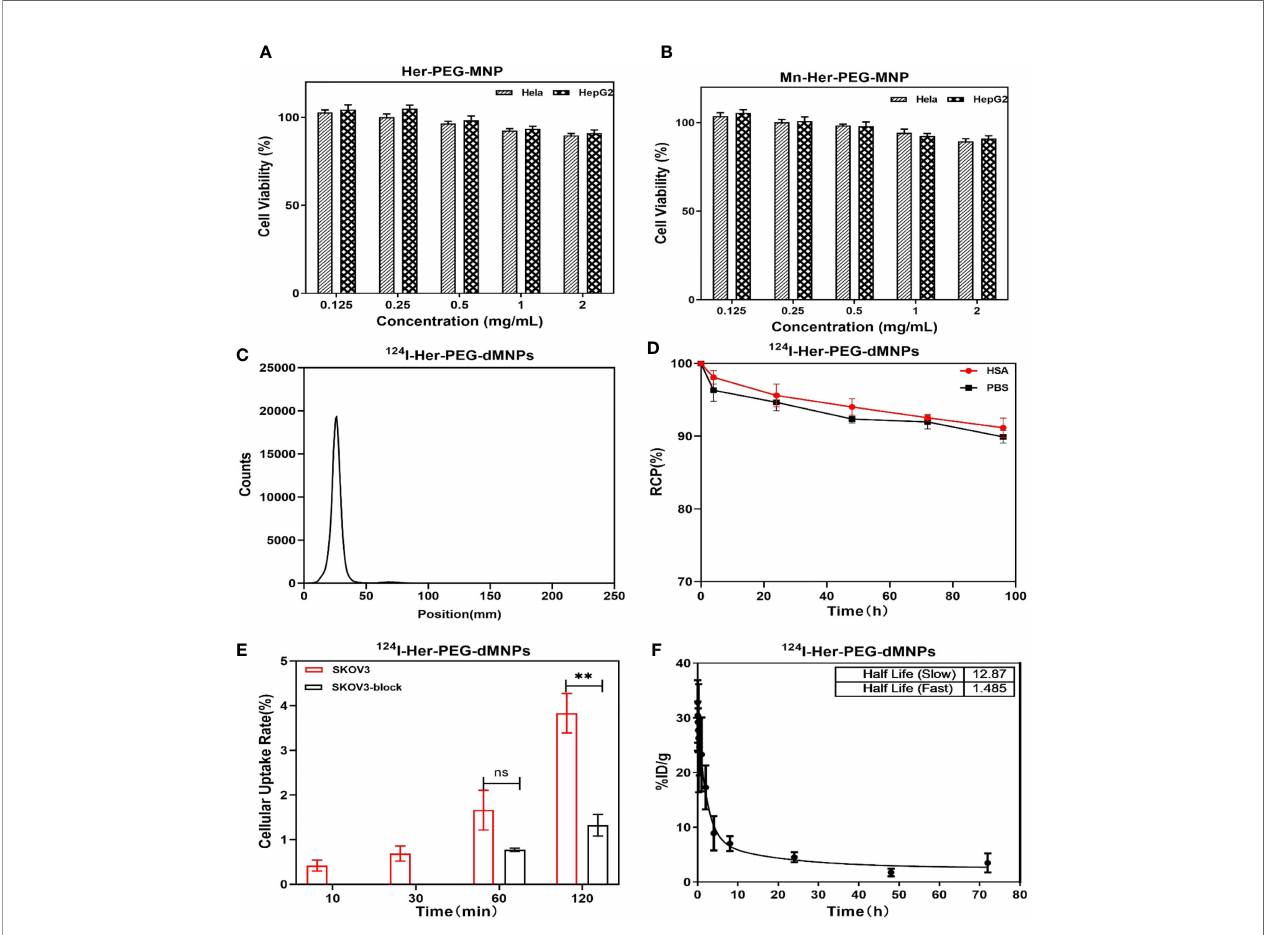
FIGURE 2 | MTT assay using HeLa and HepG2 cells with (A) Her-PEG-dMNP and (B) Mn-Her-PEG-dMNP concentrations of 0.125, 0.25, 0.5, 1, and 2 mg/ml after incubation at 37°C. (C) Radio-TLC chromatogram of 124 I-Her-PEG-dMNPs. (D) The in-vitro stability of 124 I-labeled Her-PEG-dMNPs in PBS (pH = 7.4) and 5% HSA. (E) In-vitro cell uptake of 124 I-Her-PEG-dMNPs in SKOV-3 cells. (F) Blood radioactivity pro fi le of 124 I-Her-PEG-dMNPs. Data were expressed as mean ± SEM. All the numerical data are presented as mean ± SD. *P < 0.05; **P < 0.01; ***P < 0.001 by two-way ANOVA. The symbols ** indicates statistically signi fi